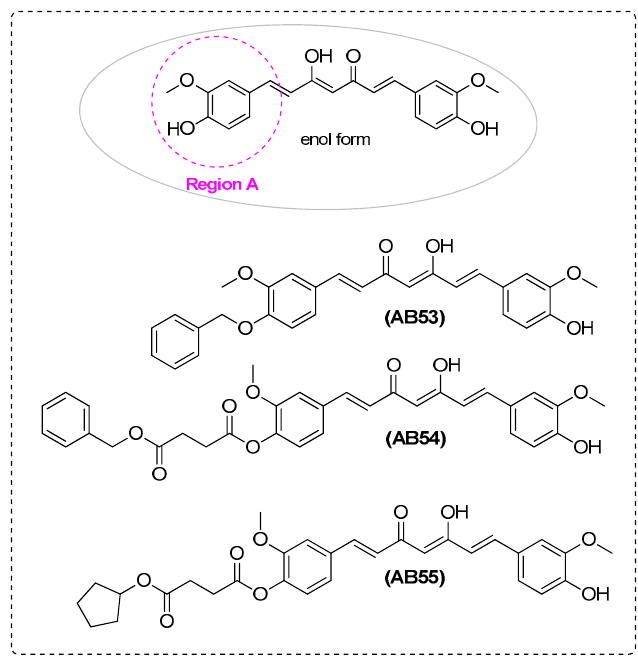
Figure 7. inhibitors. Figure 7. Anti-inflammatory inhibitors.